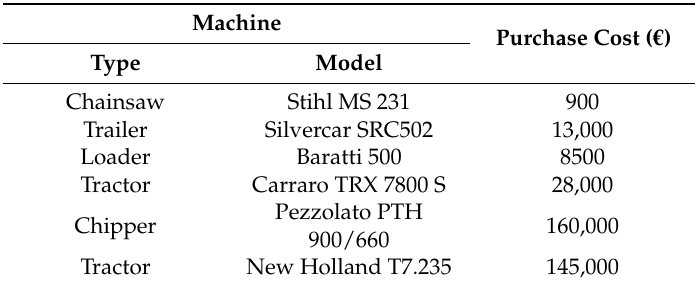
Table 1. Machine purchase costs considered in the economic